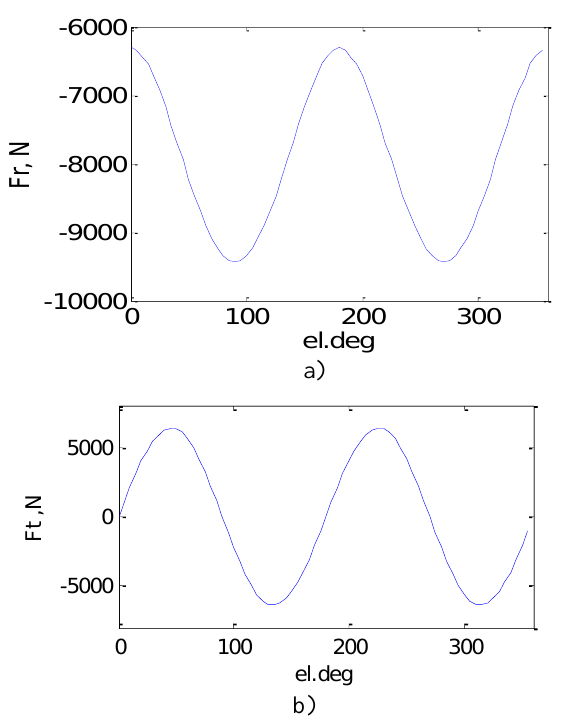
Fig. 5. Forces acting on the coil assembly: a) force in the radial direction; b) force in the tangential direction.